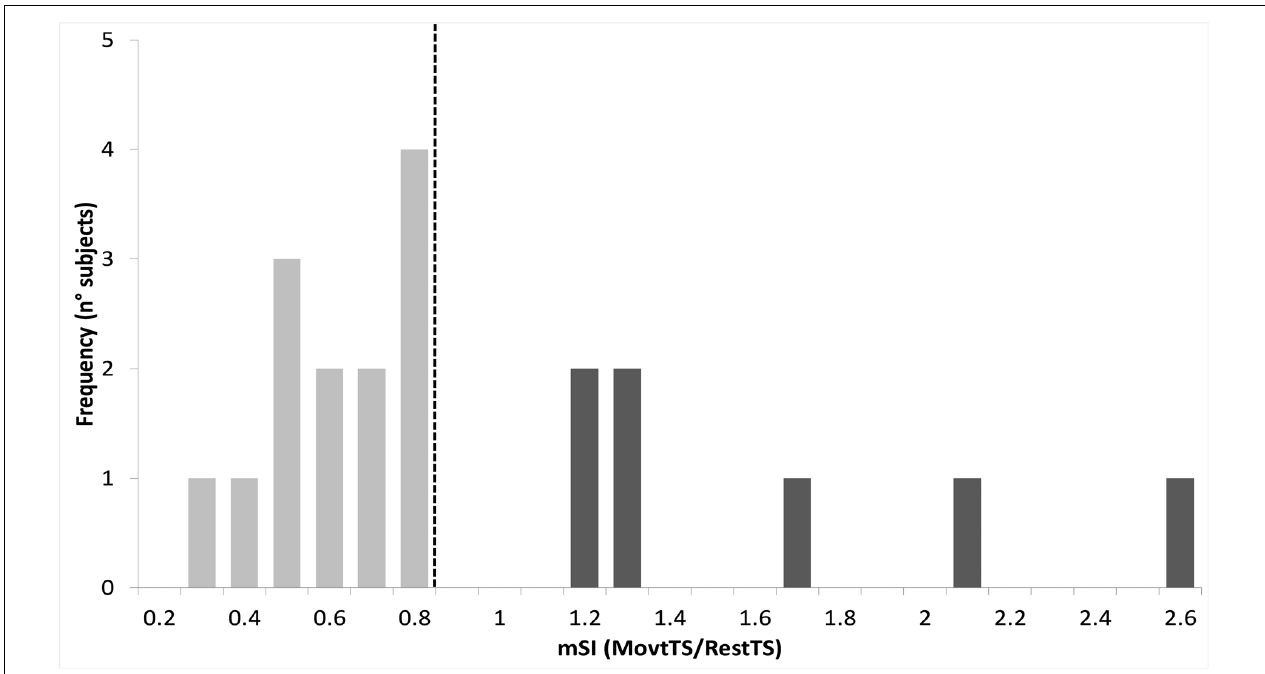
FIGURE 5 | Histogram of motor surround inhibition (mSI) distribution. Vertical dashed line represents a priori cut-off value for mSI determination (movtTS/RestTS < 0.8). Subjects who showed lower values than the cut-off were assigned to mSI group (light gray), whereas those showing higher values were assigned as NOmSI group (dark